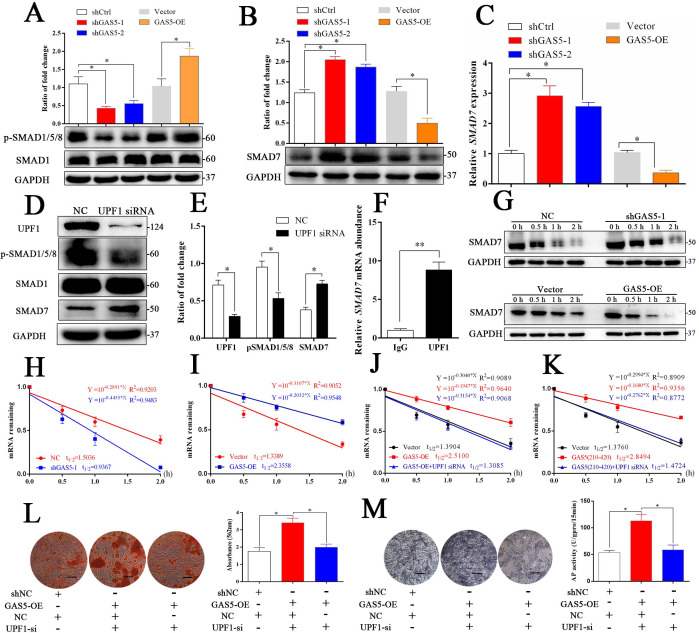
GAS5 interacts with UPF1 to accelerate SMAD7 decay.(A) Western blot analysis of the activation pathway (pSMAD1/5/8, SMAD1) in GAS5 knockdown or overexpression conditions. (B) SMAD7 was regulated by GAS5 knockdown or overexpression by western blot. (C) Relative SMAD7 mRNA levels in GAS5 knockdown or overexpression cells tested by qRT-PCR. (D, E) Western blot analysis and quantification of pSMAD1/5/8/SMAD1 and SMAD7 in the UPF1 knockdown and control groups. (F) RIP assay with anti-UPF1 showed the binding of UPF1 and SMAD7 mRNA. (G) Western blot analysis in the GAS5 knockdown, overexpression and control groups after actinomycin D treatment. NC means the negative control siRNA transfected group. It was also be treated by Actinomycin D but as the control of GAS5 shRNA-1. (H) Relative SMAD7 mRNA expression in the GAS5 knockdown and control groups by actinomycin D treatment tested by qRT-PCR. (I) Relative SMAD7 mRNA expression in the GAS5 overexpression and control groups by actinomycin D treatment tested by qRT-PCR. (J, K) Relative SMAD7 mRNA expression by actinomycin D treatment under the condition of UPF1 siRNA, overexpression of a truncated form of GAS5 or GAS5 full-length. (L) ARS staining and quantification in the GAS5 overexpression and UPF1 siRNA groups. Scale bar, 500 µm. (M) ALP staining and ALP tests in the GAS5 overexpression and UPF1 siRNA groups. Scale bar, 500 µm. Each cellular experimental group was repeated at least three times.